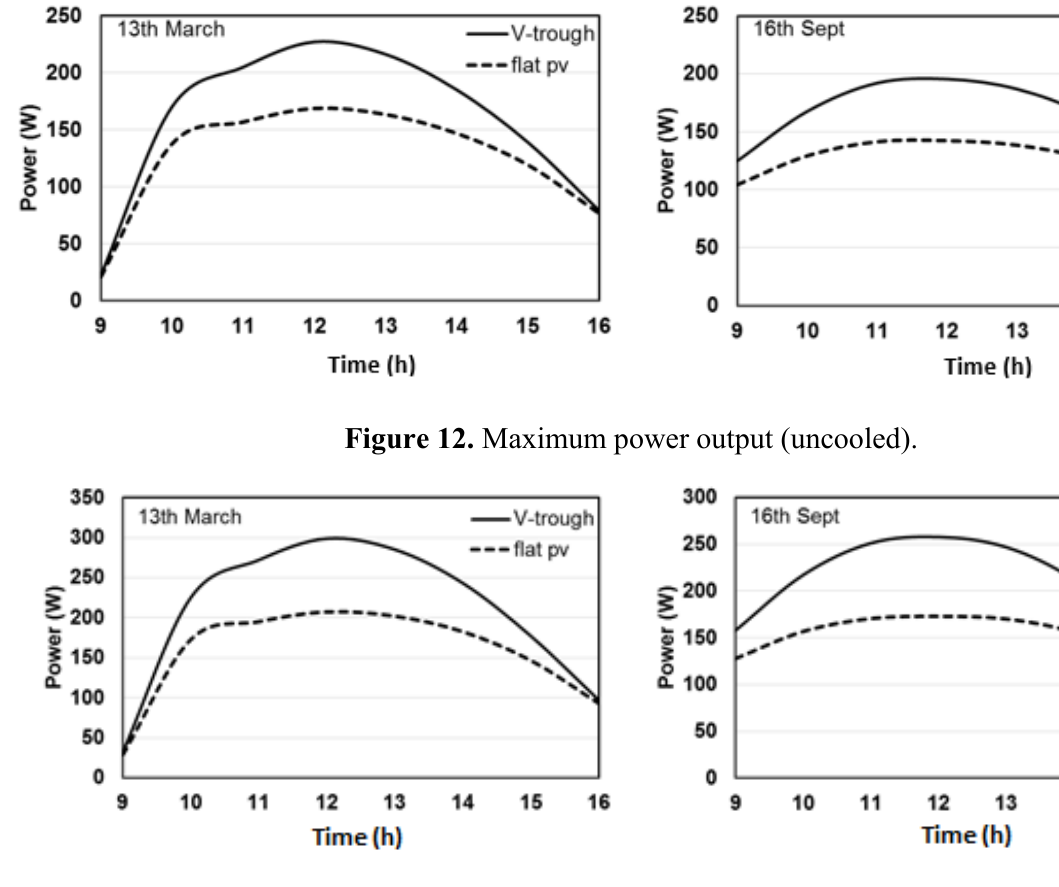
Figure 13. Maximum power output (cooled).